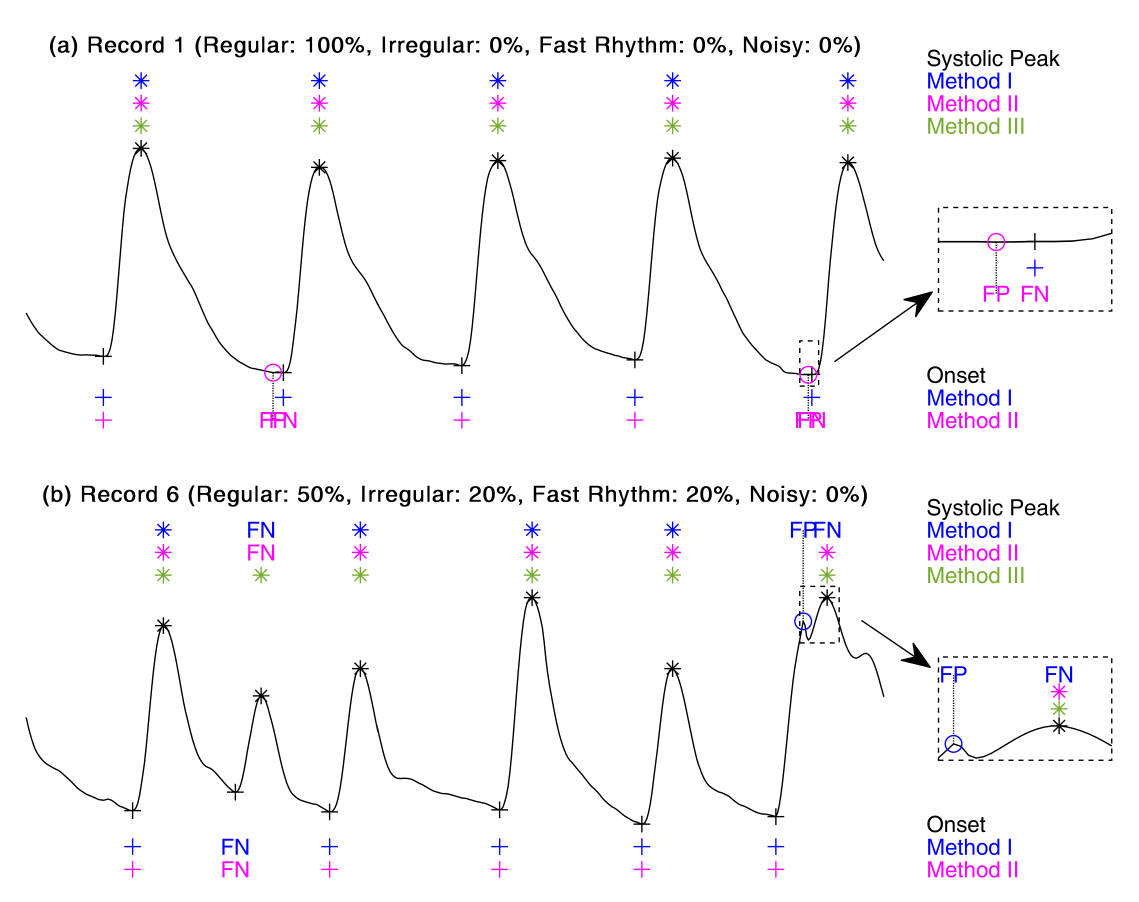
Figure 6. Comparison of the three methods’ results. ( a ) Four-second segment of Record 1. ( b ) Four-second segment of Record 6. The black ‘*’ and ‘+’ refers to the annotated systolic peaks and onsets, respectively. The blue, magenta and dark-green ‘*’ are the true-positive systolic peaks of Methods I, II, and III, respectively. The blue and magenta ‘+’ are the true-positive onsets of Methods I and II, respectively. ‘FP’ and ‘FN’ are the false-positive and false-negative, respectively. The ‘ ◦ ’ is used to show the location of the